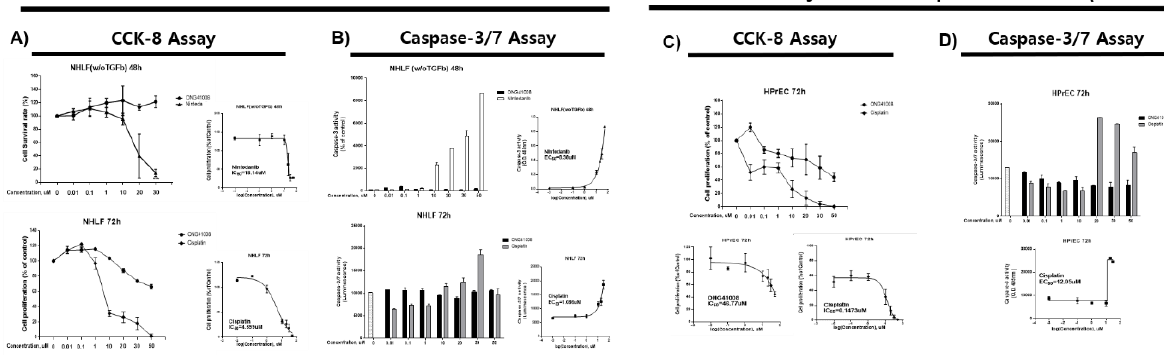
Figure 9. A comparison of the apoptotic effects of ONG41008, nintedanib, and cisplatin and the survival rate of NHLFs and HPrECs. ( A ) NHLFs were stimulated with ONG41008 or nintedanib for 48 h and stimulated with ONG41008 or cisplatin for 72 h. The cell survival rate was measured using a CCK-8 assay. The IC 50 values of nintedanib and cisplatin were calculated. ( B ) NHLFs were stimulated with ONG41008 or nintedanib for 48 h and stimulated with ONG41008 or cisplatin for 72 h. An activated caspase-3 assay was performed, and the EC 50 values of nintedanib and cisplatin were calculated. ( C ) Human prostate epithelial cells (HPrECs) were stimulated with ONG41008 or cisplatin for 72 h. The cell survival rate was measured using a CCK-8 assay. The IC 50 values of ONG41008 and cisplatin were calculated. ( D ) HPrECs were stimulated with ONG41008 or cisplatin for 72 h. An activated caspase-3 assay was performed, and the EC 50 value of cisplatin was calculated with a sigmoidal, four-parameter logistic in GraphPad Prism, version 7.00. The standard deviation was derived from three independent experiments. Supplementary Materials Video S4 clearly showed that ONG41008 was not toxic to the normal primary human